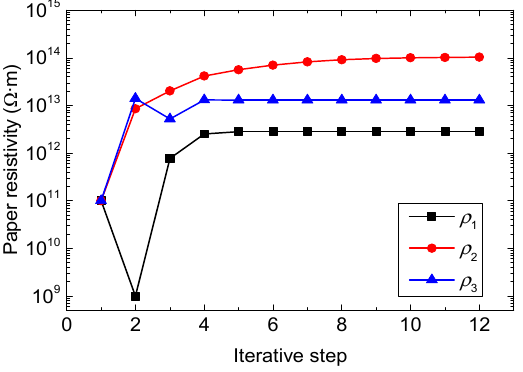
Table 4. Final results of paper resistivity iterative inversion.